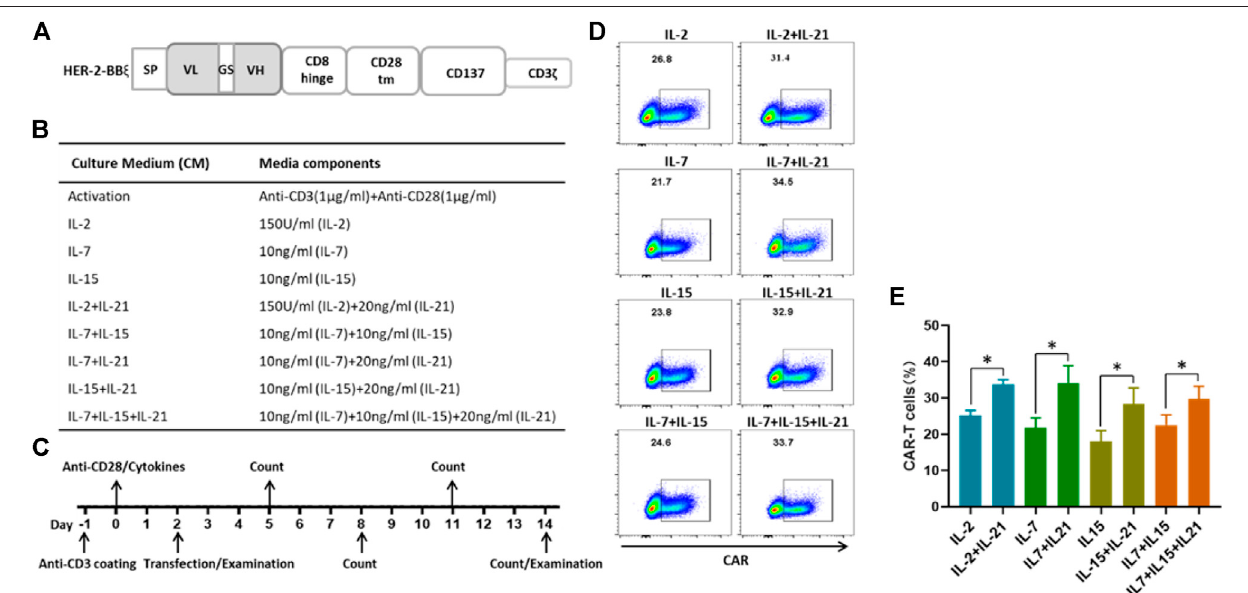
FIGURE 1 | IL-21 enhances the transduction ef fi cience of T cells (A) Schematic diagrams of lentiviral HER-2 CAR structures. (B) Culture conditions of different protocols for the generation ofHER-2 CAR-T cells. (C) Time schema ofmain experimental manipulation for thegeneration of HER-2 CAR-T cells. (D,E) CAR expression inCD3 + TcellstransfectedusinglentiviralvectorscontainingtheindicatedHER-2-CARconstructsasmeasuredby fl owcytometryonthe12thdayaftertransfection.Data from one representative donor and summary for three independent donors in independent expansions was shown (mean ± SEM), results were compared using Student ’ s t -test (* p < 0.05, ** p <